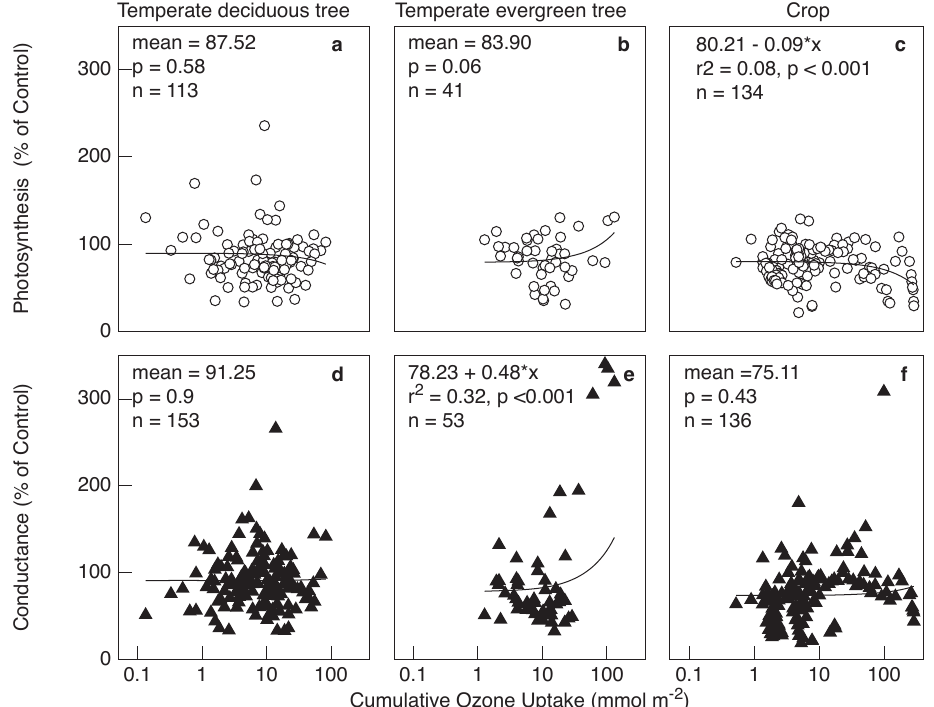
Fig. 6. The correlation of photosynthesis (open symbols; a–c ) and conductance (closed symbols; d–f ) to CUO for temperate deciduous trees (a, d) , temperate evergreen trees (b, e) and crops (c, f) for all data that is compared to control plants exposed to charcoal-filtered air with medium or high confidence in cumulative O 3 uptake (CUO) calculations. Response values are reported as % of control (treatment/control). CUO is shown on a log scale, but linear analyses ( r 2 and line equations) were performed on non-log transformed data. r 2 values are only included for significant correlations, and n values are the number of data points included in the